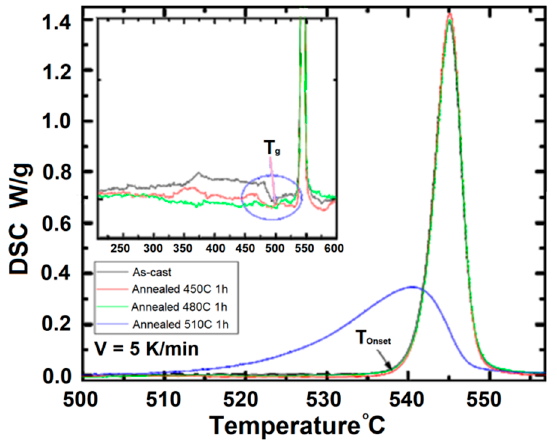
Figure 2. Differential scanning calorimetry investigation of the Co 67 Fe 3 Cr 3 B 12 Si 15 amorphous alloy. We can see in Figure 2 that the DSC curves of the as-cast ribbon (dark-grey line) and the ribbons annealed for 1 h at 450 ◦ C (red line) and 480 ◦ C (green line) are very similar. This means that the annealed tapes remained in an amorphous state. The DSC curve of the tape annealed for 1 h at 510 ◦ C (blue line) is different from the other curves. The temperature of the onset of crystallization and the height of the maximum are lower than those of the other samples’ thermograms. These changes manifest the crystallite presence in the amorphous